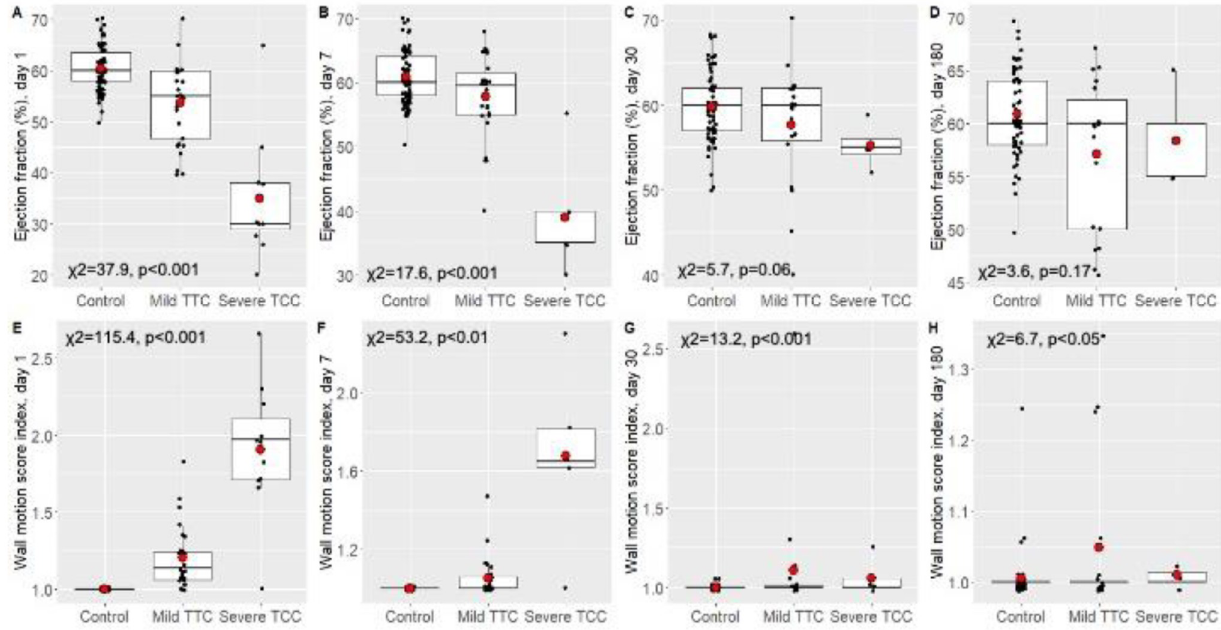
Fig 5. Differences in ejection fraction (%) (A-D) and wall motion score index (E-H) in the study groups on day 1, day 7, day 30 and day 180. Boxplots show datapoints (black dots; jittered and outliers omitted for clarity), median, upper and lower quartiles, and minimum and maximum values; red dots indicate